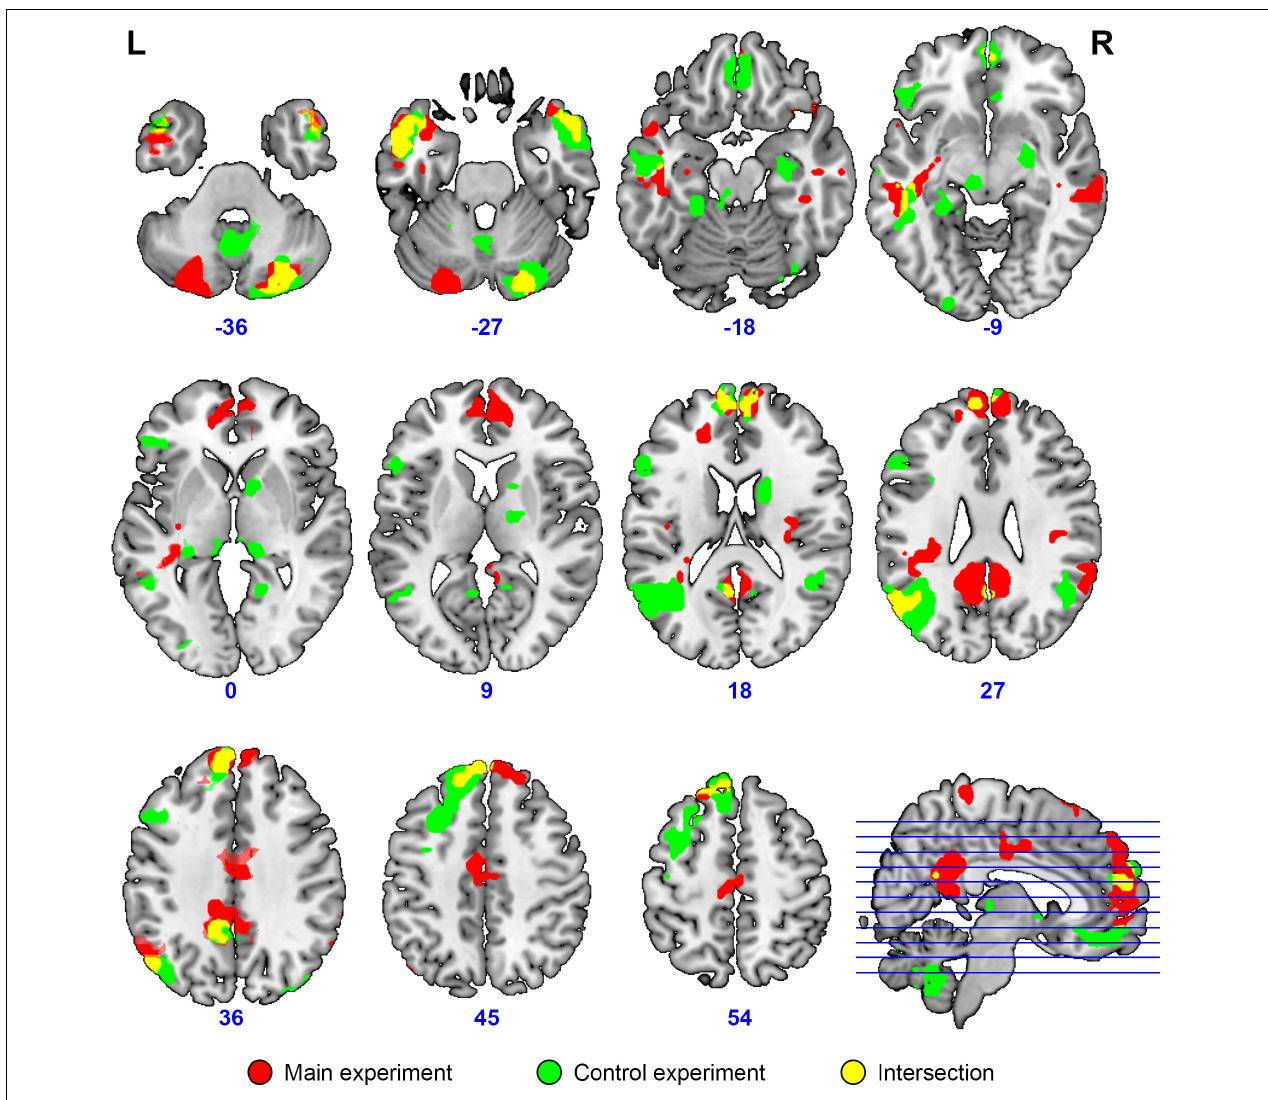
FIGURE 7 | Overlap (yellow) of brain activation specific to collective compared to individual problem solving (main experiment, red, n = 23) and specific to normal discourse comprehension compared to listening to scrambled speech (control experiment, green, N = 24). Activation was significant at the voxel-wise FDR-corrected level p < 0.05, q < 0.05, extent threshold k = 10. The image is overlaid on top of the mean MNI-space normalized anatomical images of the participants from the main experiment. Voxels activated by the scrambled speech vs. rest at the uncorrected level of p < 0.05 were excluded from the analysis at the single subject level in both